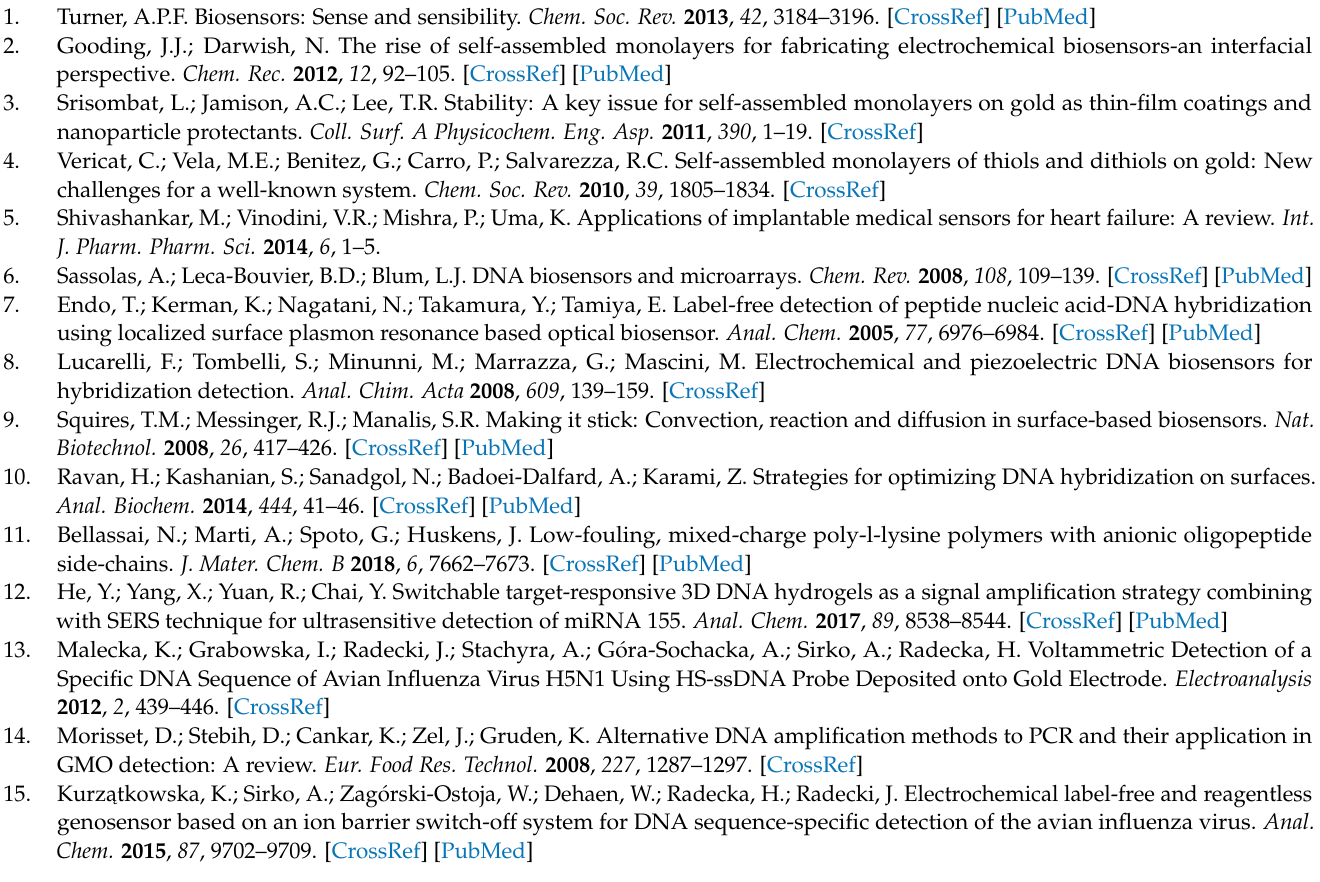
after adsorption of PLL-OEG 22 -Mal 4.6 , after reaction with HS-DNA, after hybridization with target DNA, followed by rDNA or by AuNP amplification using rDNA-AuNPs (0.66 nM) or nrDNA-AuNPs (0.7 nM, orange line). All measurements were performed in 20 mM Tris buffer with 50 µ M RuHex vs Ag/AgCl as a reference electrode (scan rate 100 mVs − 1 )., Figure S5: Representative chronocoulometry curves for gold electrodes modified with 0.25 mg/mL of PLL-OEG 22 -Mal 4.6 , before (buffer) and after reaction with 1 µ M HS-DNA, and after subsequent hybridization with AuNPs-rDNA. The signal is defined as the increment of the redox charge. Q total = Q AuNPS-rDNA -Q dl or Qs probe - Q dl , Table S1: DNA sequence employed (red sequence represents capture probe-target matching bases: green sequences represent target-reporter probe matching bases). The chosen target DNA sequence belongs to GRCH38 P13, and it is a biomarker for cervical, ovarian and gastric cancer, Table S2: The standard deviation (S) and the RSD values of the EIS measurements of all the steps for the biosensing platform. The charge transfer resistance (Rct) and double layer capacitance (Cdl) were obtained by fitting the EIS data (Figure 3) to a Randles equivalent circuit for the detection of the hybridization steps between HS-DNA, tDNA and rNDA, rDNA-AuNPs and nrDNA-AuNPs. Standard deviations are based on three individual measurements performed on different samples, for each functionalized substrate. References [21,23] are cited in the supplementary